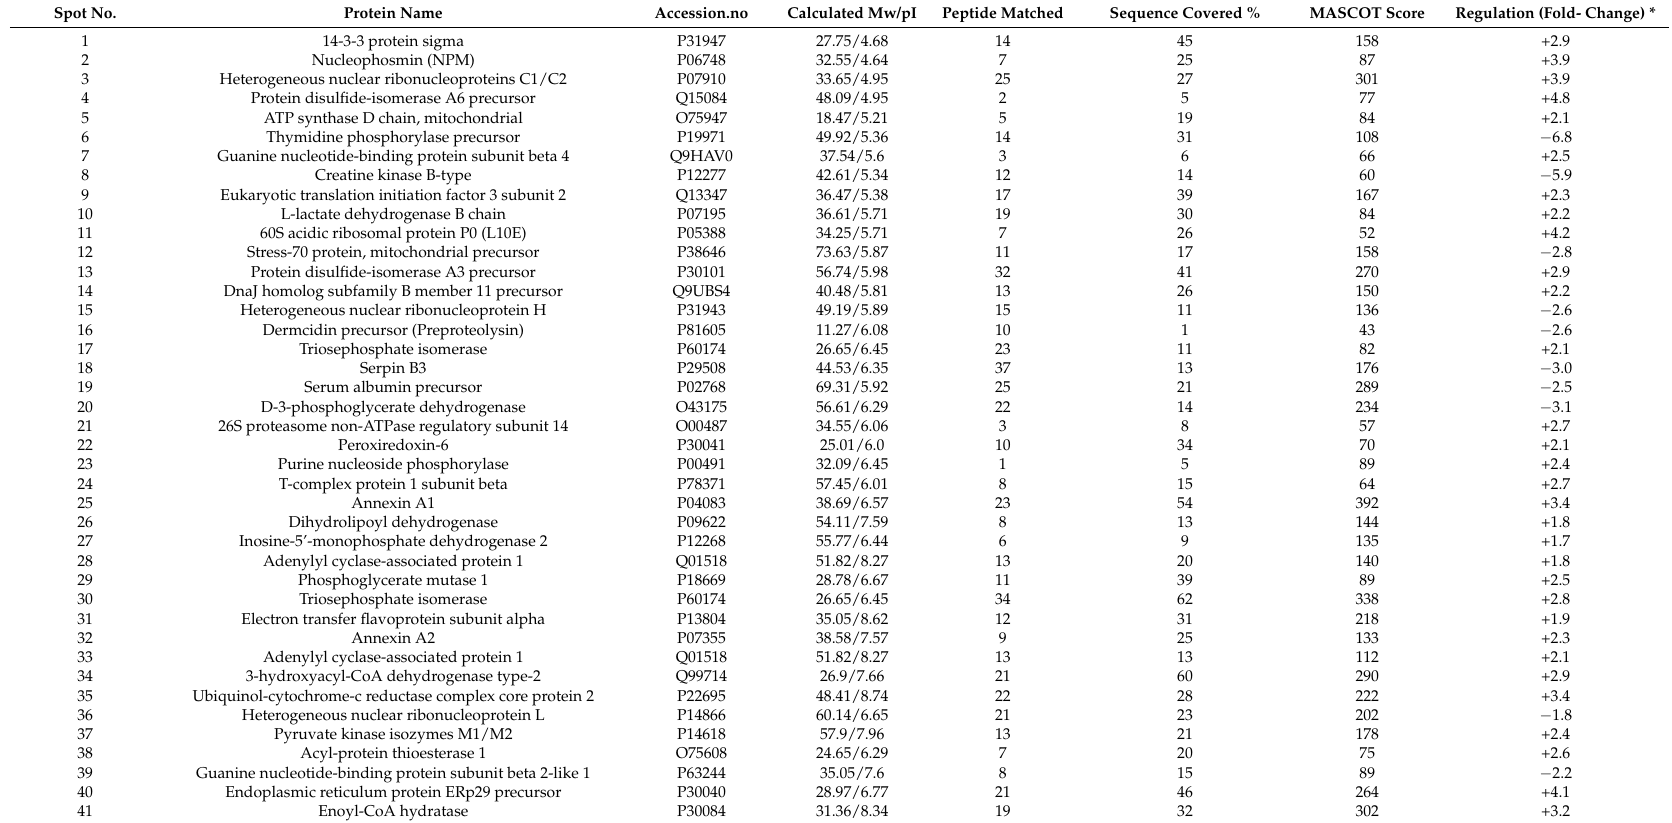
Table 1. Protein identification by